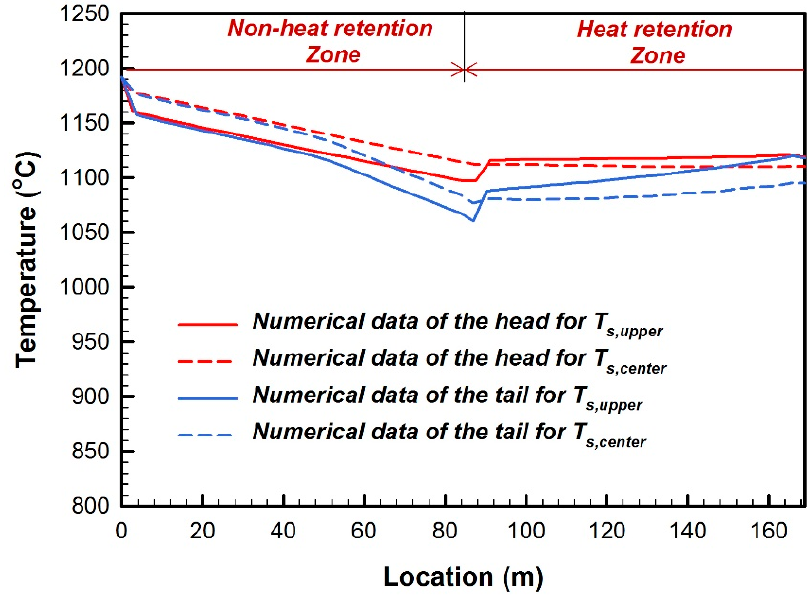
Figure 14. Numerical data for the upper surface and centerline-surface of the transfer bar with the acting-type heat retention panel (Case 2).